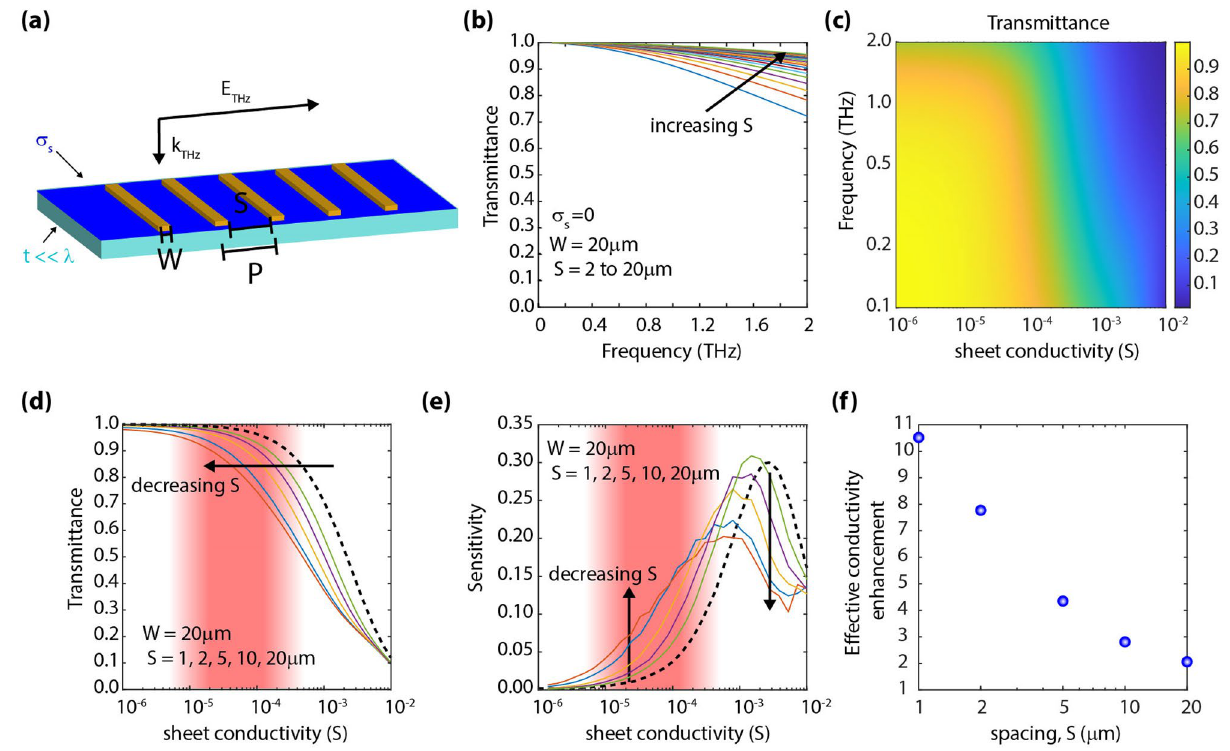
Figure 2. Effect of incorporating a non-resonant grating. ( a ) Illustration of the analyzed grating structure. (image created in Adobe Illustrator v25.0.1, https ://www.adobe .com/produ cts/illus trato r.html). ( b ) Transmittance spectra, in the absence of a conductive layer (i.e., σ s = 0), when varying S (W = 20 µm). ( c ) Colormap of transmittance versus frequency and sheet conductivity. ( d ) Passband (i.e., f < 0.2 THz) transmittance versus sheet conductivity. The dashed black curve corresponds to the case depicted in Fig. 1b; continuous colored curves correspond to S = 1, 2, 5, 10, and 20 µm. Decreasing S pushes the characteristic curves towards lower conductivity levels. ( e ) Transmission sensitivity versus sheet conductivity. The dashed black curve corresponds to the case depicted in Fig. 1c; continuous colored curves correspond to S = 1, 2, 5, 10, and 20 µm. Decreasing S increases the sensitivity at low conductivity levels as well as shifts the position of the maxima. ( f ) Effective conductivity enhancement versus spacing, S. The smaller the spacing, the larger the